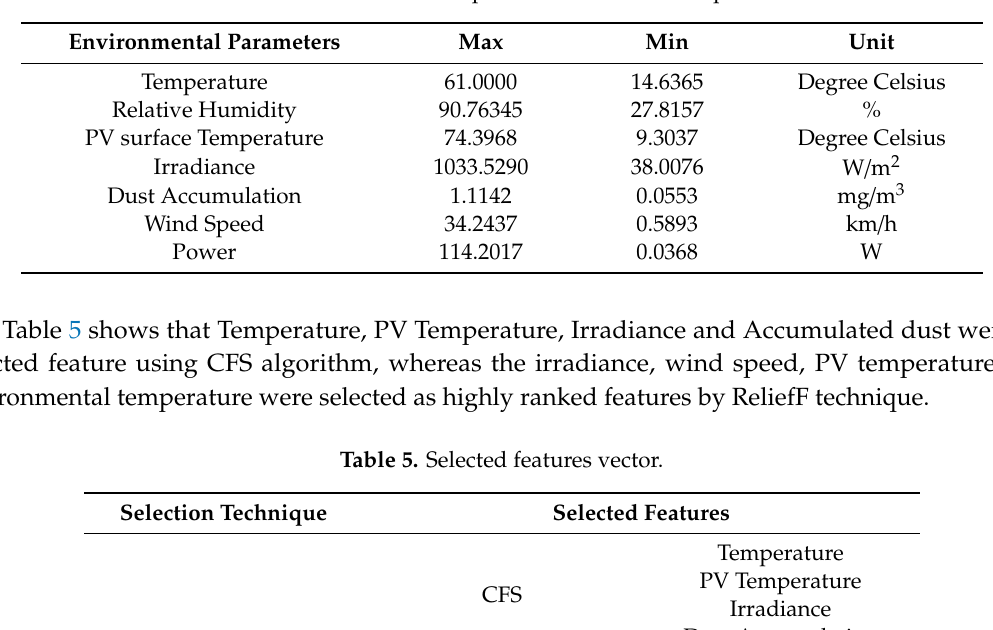
Table 4. Details of the environment parameters used for the predictive model.